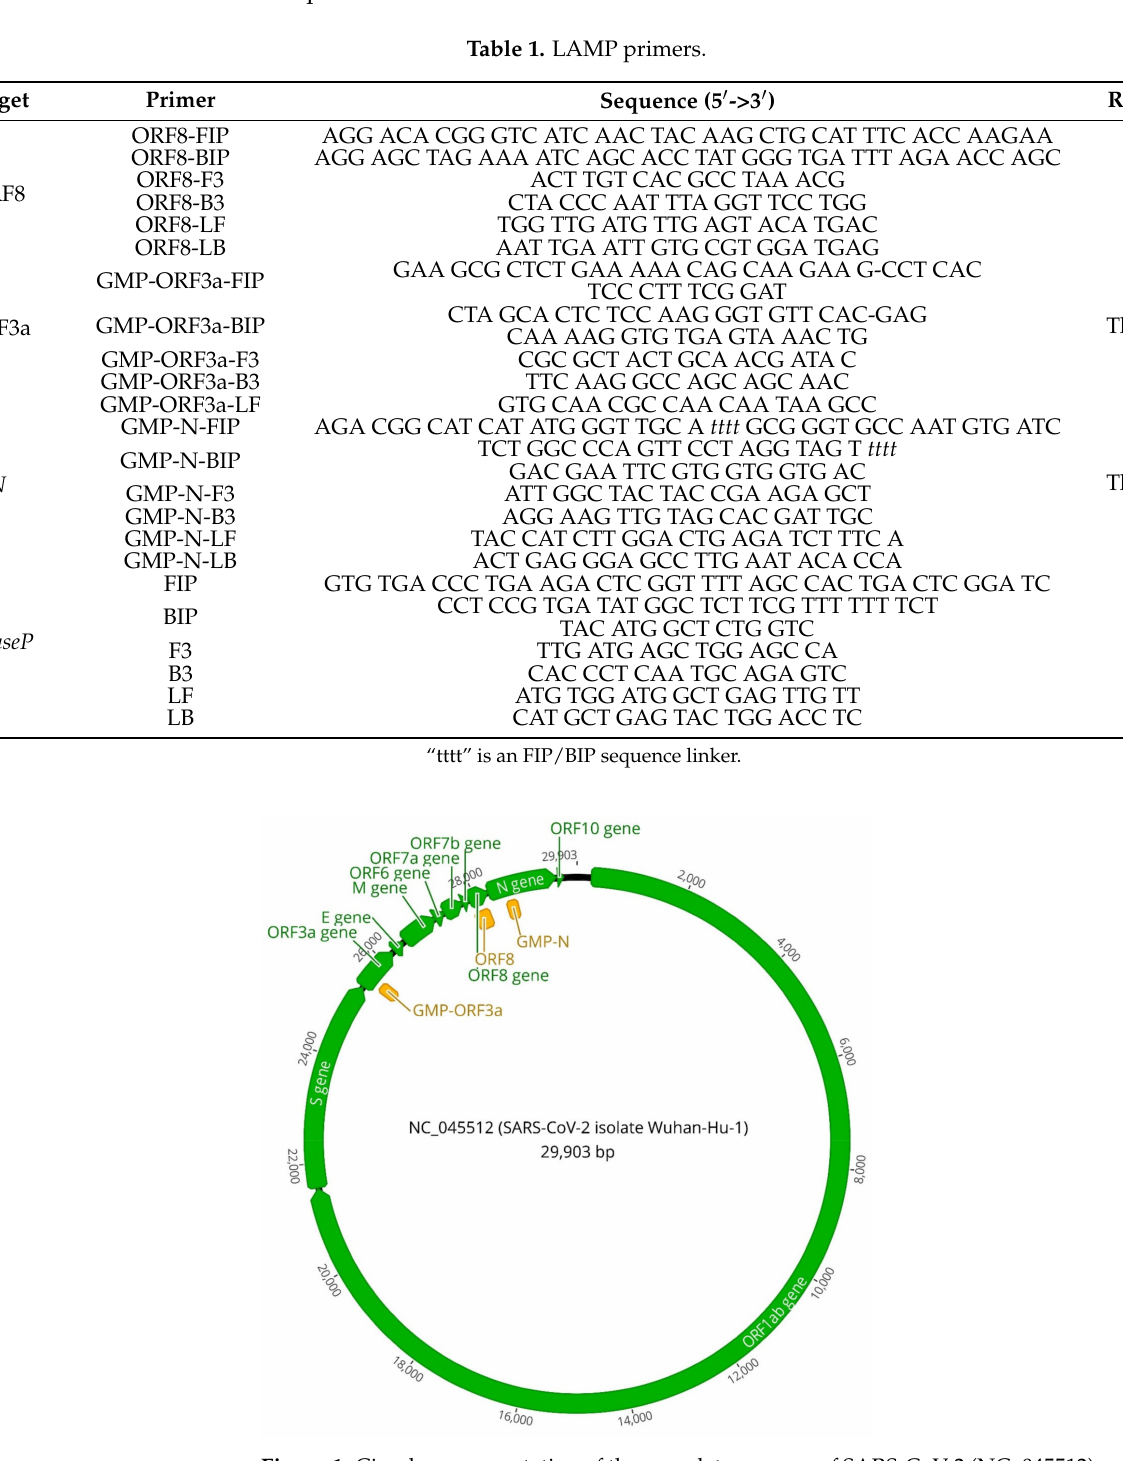
Figure 1. Circular representation of the complete genome of SARS-CoV-2 (NC_045512) corresponding to the isolate Wuhan-Hu-1, highlighting in green the different viral genes and in orange the fragments amplified by the primers selected in this